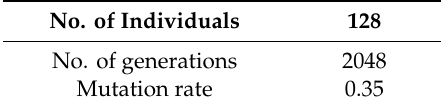
Figure 19. Heat transfer area optimization for all refrigerants.